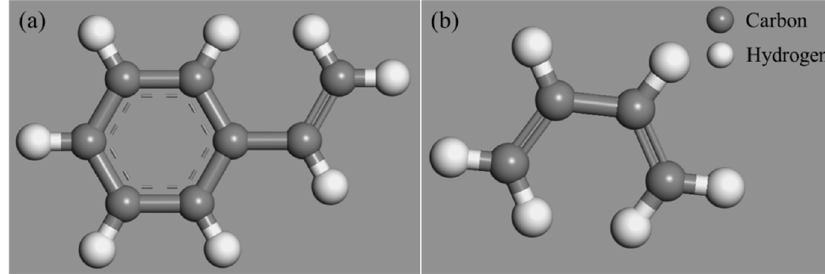
Figure 3. Monomer molecular models: ( a ) styrene; ( b ) 1,3-butadiene.